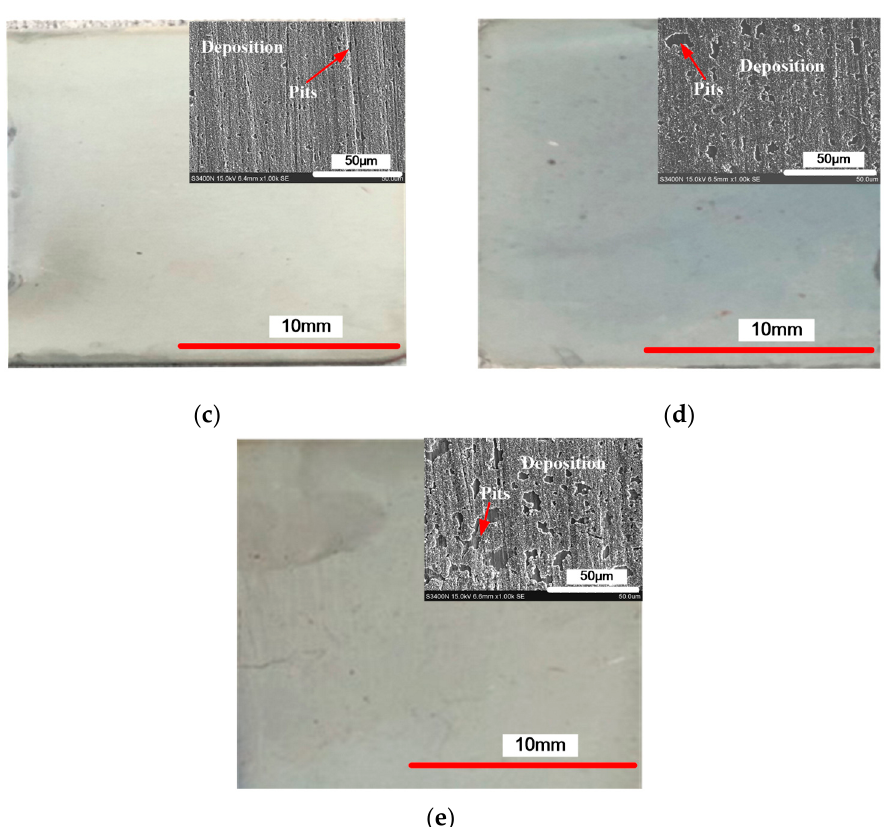
Figure 1. The surface morphology of the deposited coating with different cationic degrees. ( a ) Before deposition; ( b ) deposition without cationic polyacrylamide (CPAM); ( c ) cationic degree of 20%; ( d ) cationic degree of 40%; ( e ) cationic degree of 60%.